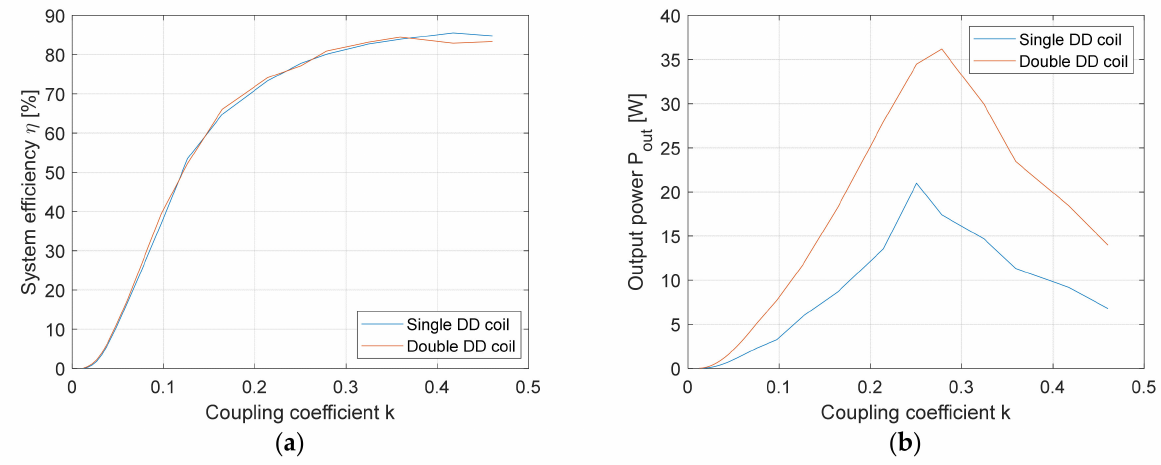
Figure 20. Comparison between the single and double DD coil structures at the frequency 87 kHz: ( a ) system efficiency; ( b ) average output